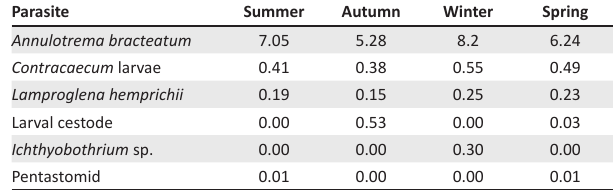
TABLE 1: Value of selected physicochemical water quality parameters (mean ± standard deviation) during four seasons (October 2014–July 2015) in the Sanyati Basin, Lake Kariba.